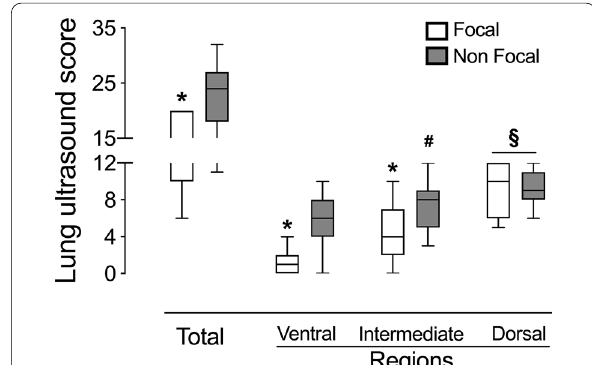
Fig. 3 Total and regional LUS score in focal and non-focal ARDS morphologies in the overall population. * p < 0.01 focal vs non-focal ARDS morphologies; # p < 0.01 Ventral vs Intermediate lung regions in non-focal ARDS morphology; § p < 0.01 Ventral and § p < 0.05